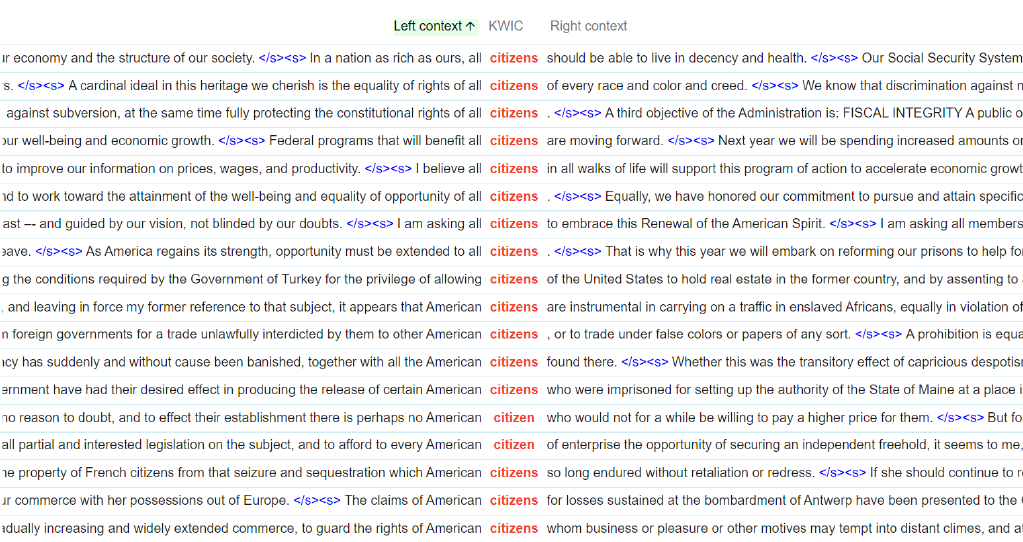
different metrics. For this study we intersect two measures: Mutual Information (MI) and